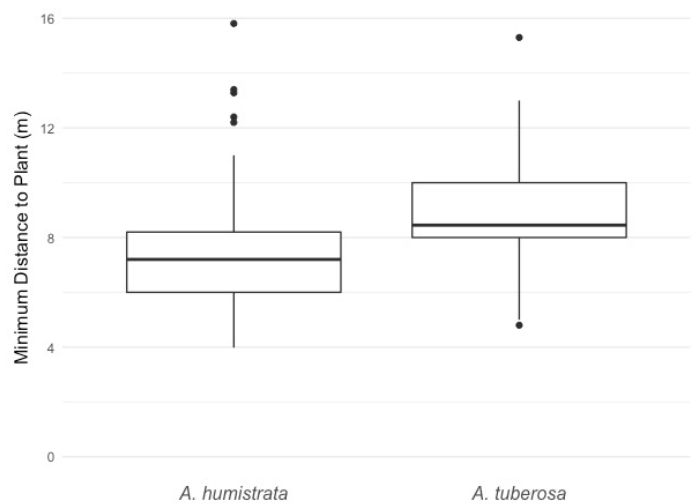
Figure 2. Box plot representing occurrences of the minimum distance between the road edge and plant among the two different milkweed species, A. humistrata ( n = 169) and A. tuberosa ( n = 29).